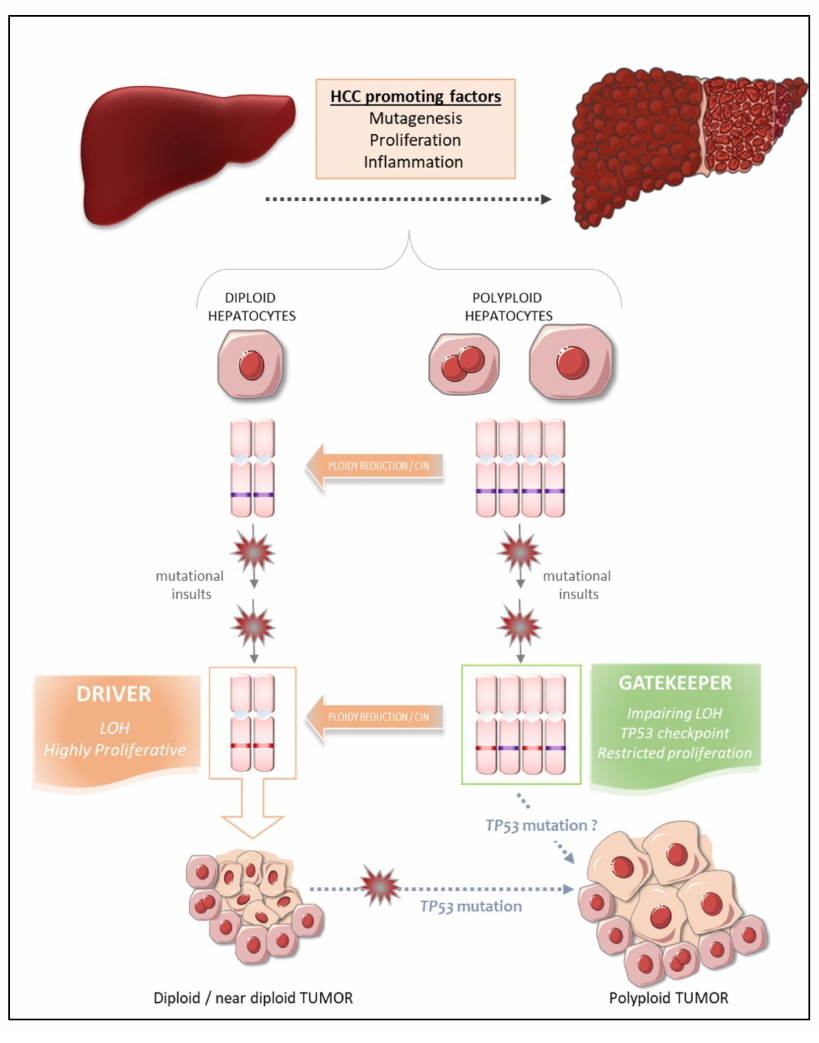
Figure 3. The two faces of polyploidy in HCC.Hepatocyte polyploidy can prevent tumor initiation by buffering loss of heterozygosity (LOH) and mutations of tumor suppressor genes. In addition, the limitation of proliferation mediated by the p53 checkpoint in the polyploid state, may prevent the expansion of potentially transformed clones. It is, therefore, thought that liver tumors stem from diploid hepatocytes: diploid hepatocytes exposed to multiple oncogenic insults are more prone to loss of heterozygosity. The gatekeeper phenotype of hepatocyte polyploidy can be impaired following ploidy reduction. This phenomenon can generate progenies of lower ploidy displaying chromosomal instability (CIN) that are more likely to undergo transformation following additional tumorigenic hits. TP53 mutation may also favor the development of polyploid tumors, which are known to be more aggressive and to have a poorer